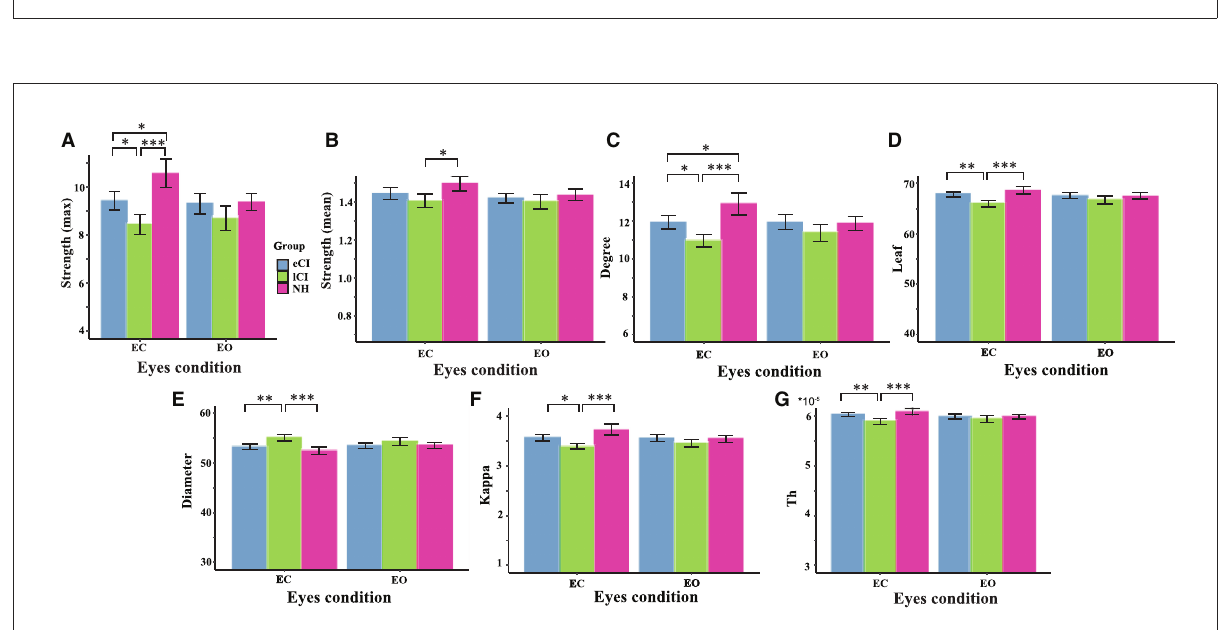
FIGURE8 Comparison of network characteristics between the eyes-closed (EC) and eyes-open (EO) conditions in children with early cochlear implantation (eCI), children with late cochlear implantation (lCI), and children with normal hearing (NH) groups in the alpha band (8–13 Hz). MST characteristics in the alpha band are shown for the eCI group (blue), lCI group (green), and NH group (red) for both the EO and EC conditions (x-axis). The main group differences were found for (A) strength (max), (B) strength (mean), (C) degree, (D) leaf, (E) diameter, (F) kappa, and (G) tree hierarch (Th). ∗ p < 0.05, ∗∗ p < 0.01, and ∗∗∗ p <